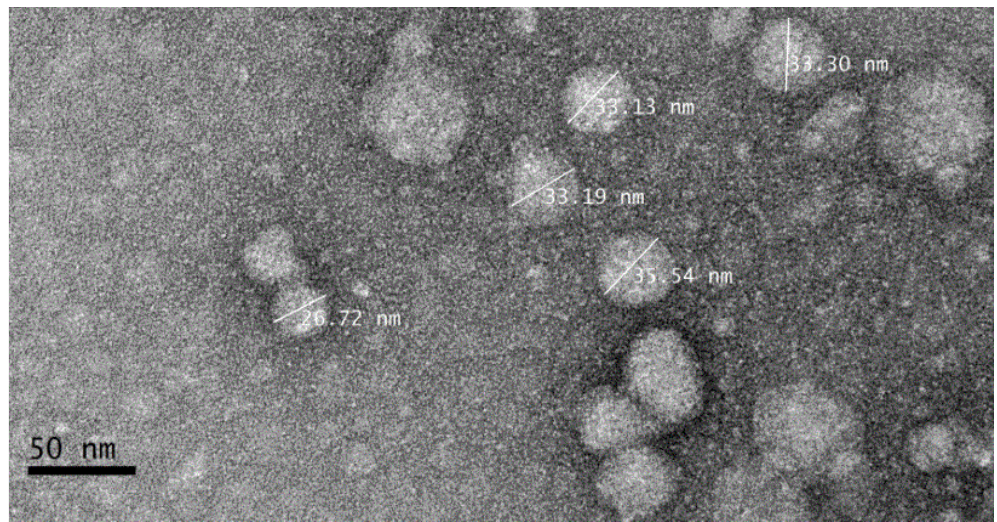
Figure 6. Transmission electron microscopy of Cur/ALG-GA NPs.